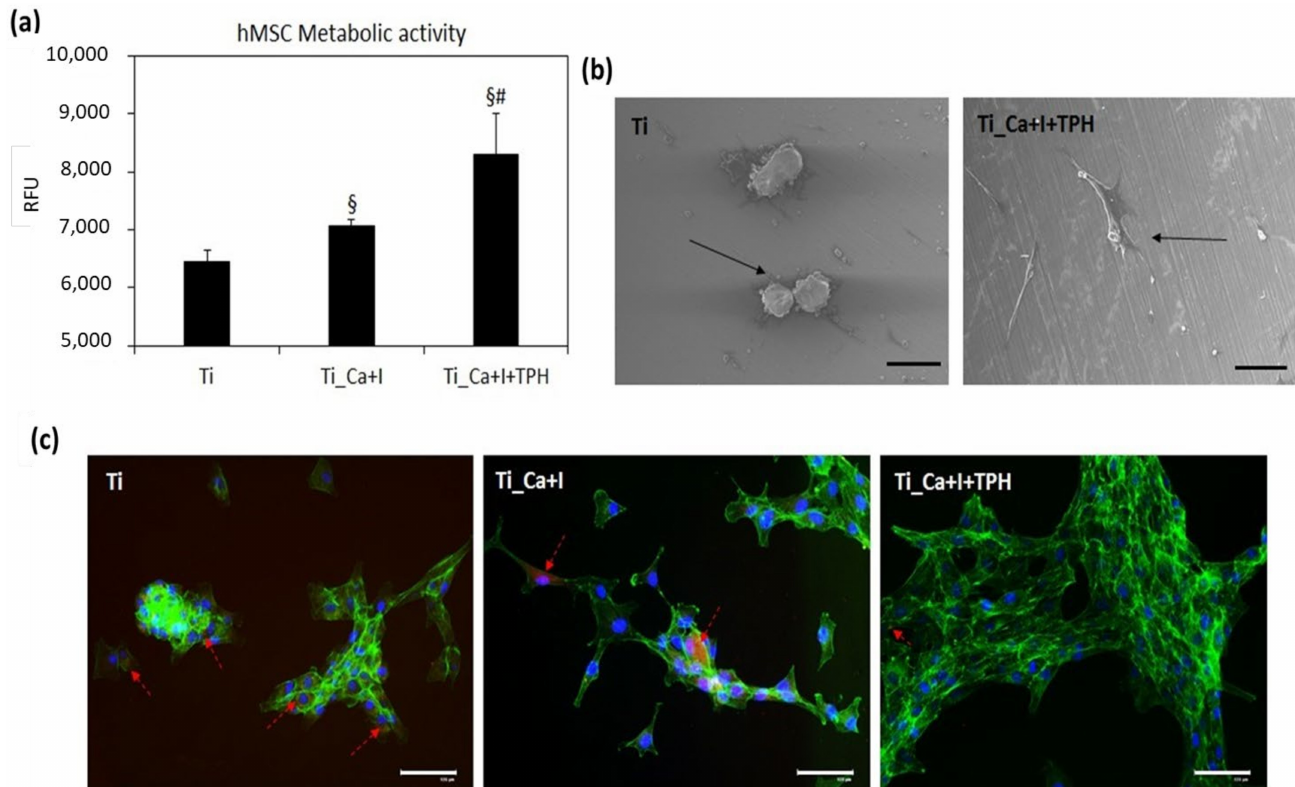
Figure 10. Pre-inflammatory evaluation. When the inflammatory environment was generated before cell seeding, the presence of iodine + polyphenols (Ti_Ca+I+TPH) protected cells from oxidative stress, as they showed the highest metabolism (( a ), p < 0.05 in comparison with Ti and Ti_Ca+I, indicated by § and #, respectively) and a proper morphology in SEM images ( b ). The toxic effect was due to the active species internalization, as shown in the CellRox staining (( c ), positive cells stained in red) where most of the resulting cells were protected by the iodine and polyphenol. Bars represent means ± st. dev, replicates = 3. SEM images: 180 × magnification, bar scale = 100 µ m; fluorescent images bar scale = 125 µ